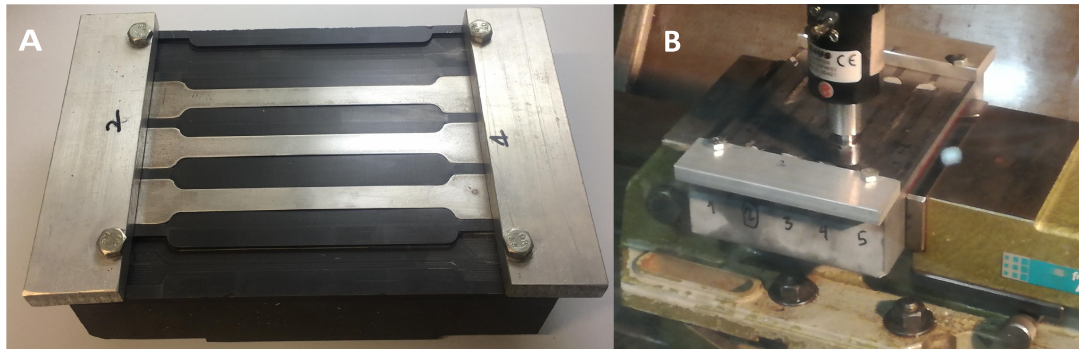
Figure 1. ( A ) Three tensile specimens fitted in the epoxy equipment. ( B ) Burnishing tool while treating the